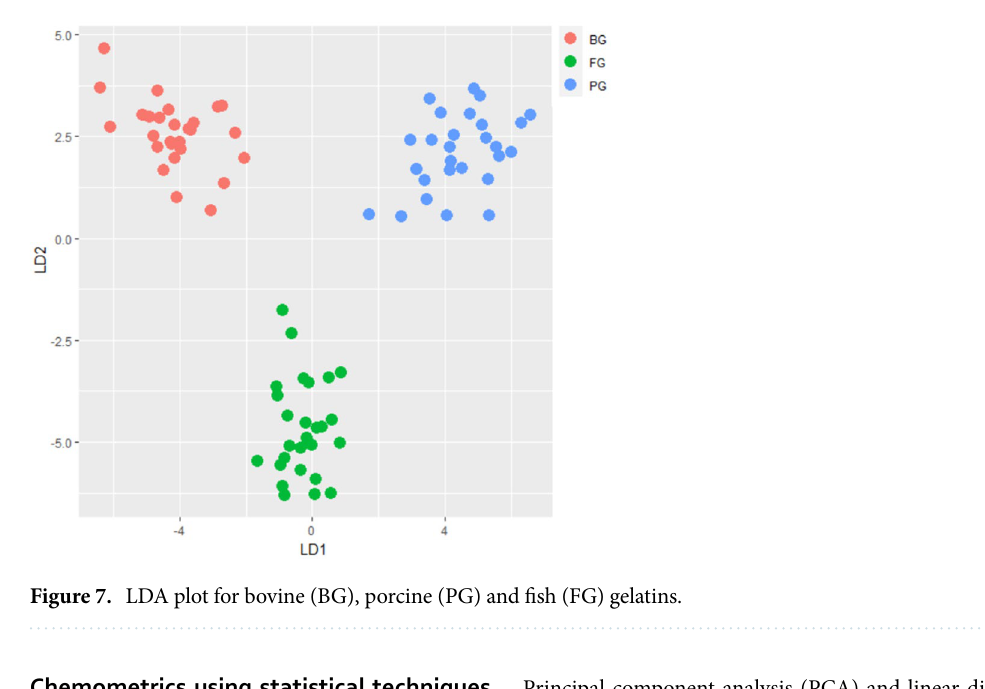
Figure 6. PCA ( a ) score plot and ( b ) loading plot for bovine (BG), porcine (PG) and fish (FG) gelatins.